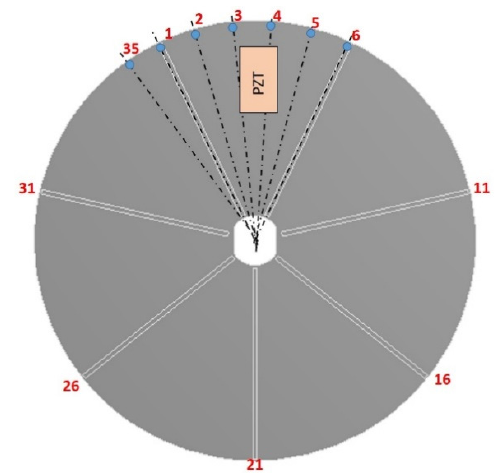
Figure 9. Modal analysis of the bladed disk. Positions measured with the LDV.